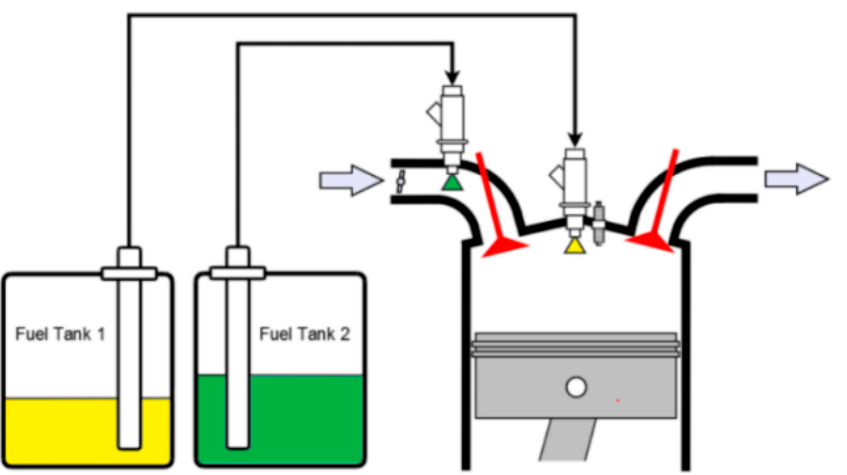
Figure 14. Schematic diagram of fuel supply system for ammonia-blended hydrogen hybrid fuel engine.